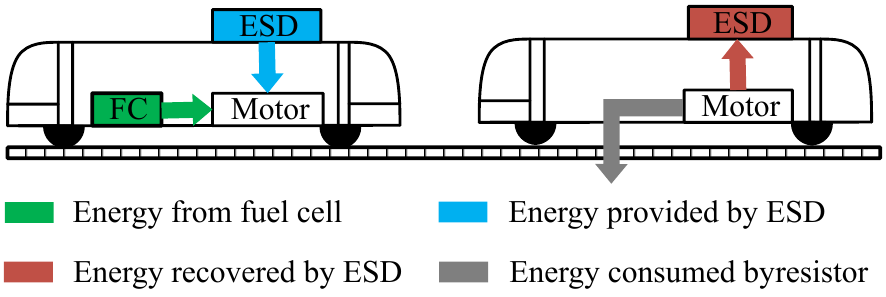
Figure 2. Energy flow during the traction and regenerative braking operations of an FCHT. Fuel cell (FC) and ESD both provide energy to the electric motor during traction mode and the electric motor conducts regenerative braking to charge ESD or convert the energy directly into heat in braking resistors.